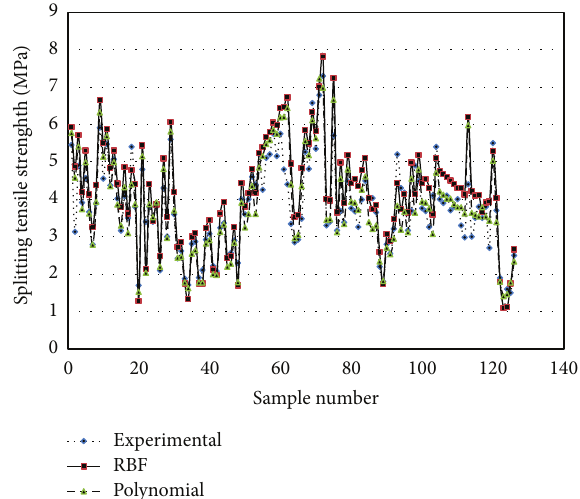
Figure 3: Comparison of experimental results to training results of SVM-II.